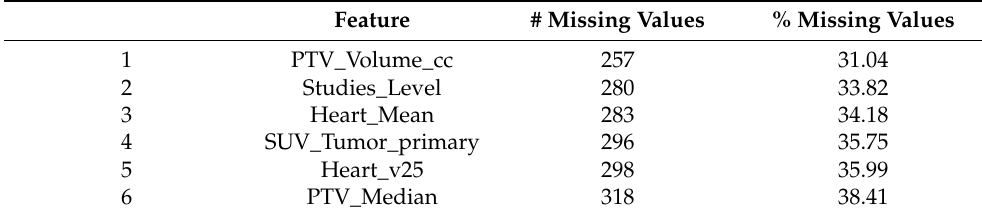
Table 1. The list of six features eliminated from the original dataset because the number of present missing values (# Missing Values) exceeds the threshold